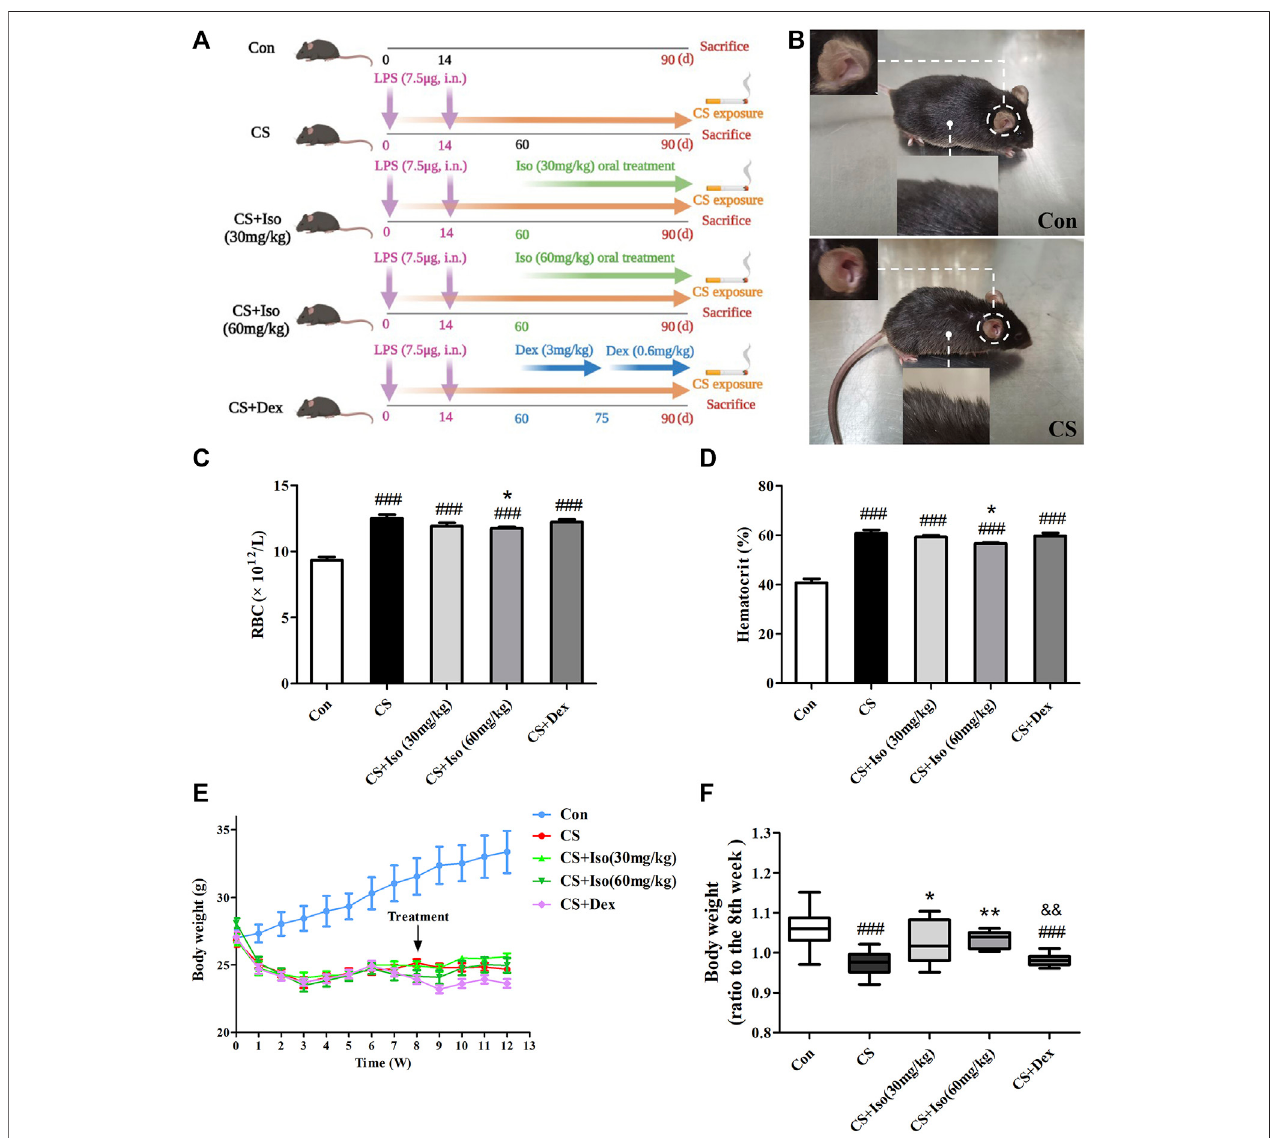
FIGURE2| IsoimprovesCS-inducedbodyweightloss,increasesinRBCandHCTinmice. (A) TheexperimentalprocedureofCSexposureplusLPSinstillationas well as Iso or Dex treatment. (B) The appearance of COPD mice was signi fi cantly different from that of the control group. (C,D) The RBC count and hematocrit were measured in whole blood ( n = 5 mice per group). (E) Mouse weight changes during the experiments. (F) The improvement of body weight in each group was evaluated ( n =15micepergroup).Datawasshownasmean(±SD) (A – E) andmedian(±IQR) (F) .Totestforgroupdifferencsesone-wayANOVA (A – E) andKurskal-Wallis (F) were applied. ### p < 0.001 vs. control group, * p < 0.05, ** p < 0.01 vs. CS group and && p < 0.01 vs. CS + Iso 60 mg/kg group.